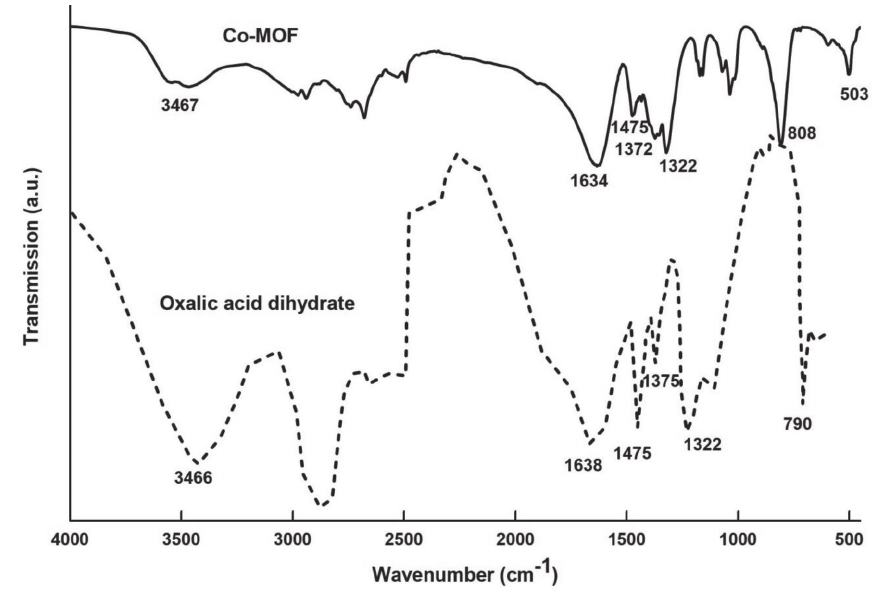
Fig. 4 – FTIR spectra of Co-MOF and oxalic acid